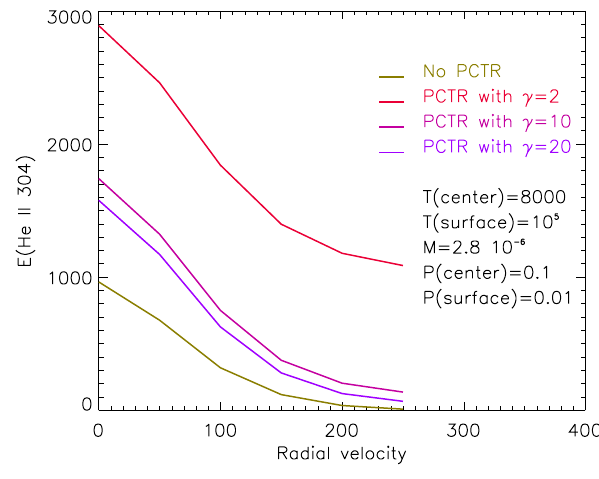
Fig. 2. Variation of the He II λ 304 ˚A line intensity (in − 1 ) as a function of the radial velocity of the ergs − 1 cm − 2 sr − 1 ˚A prominence plasma (in kms − 1 ) for 4 different types of prominence